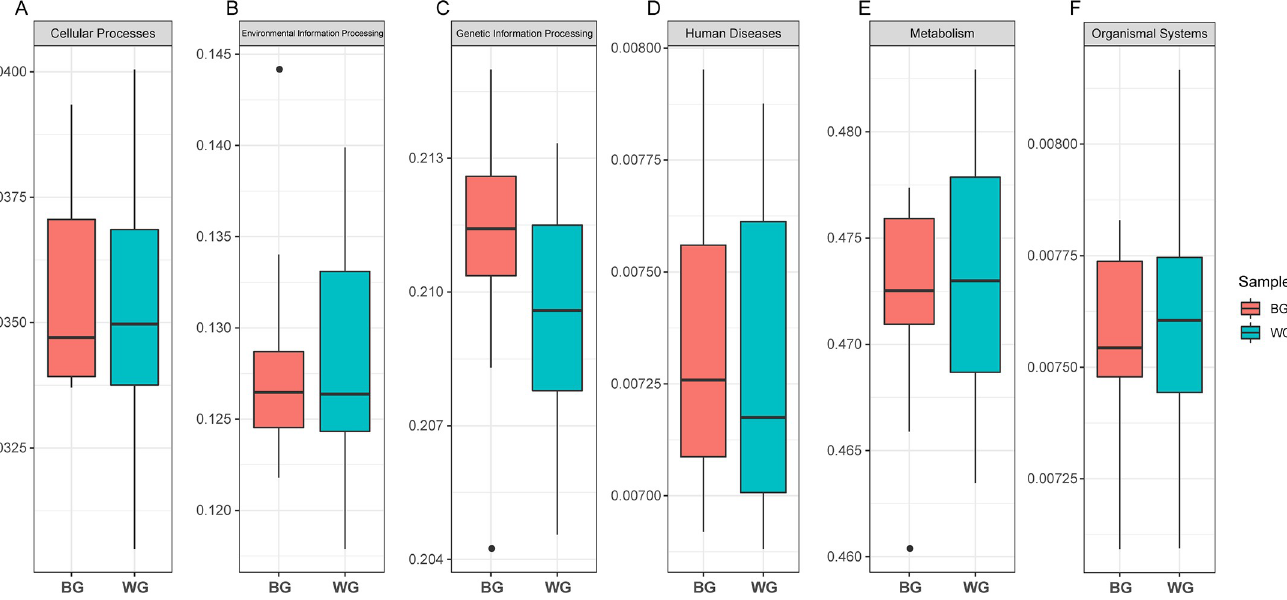
Fig 5. The primary metabolic pathways between BG and